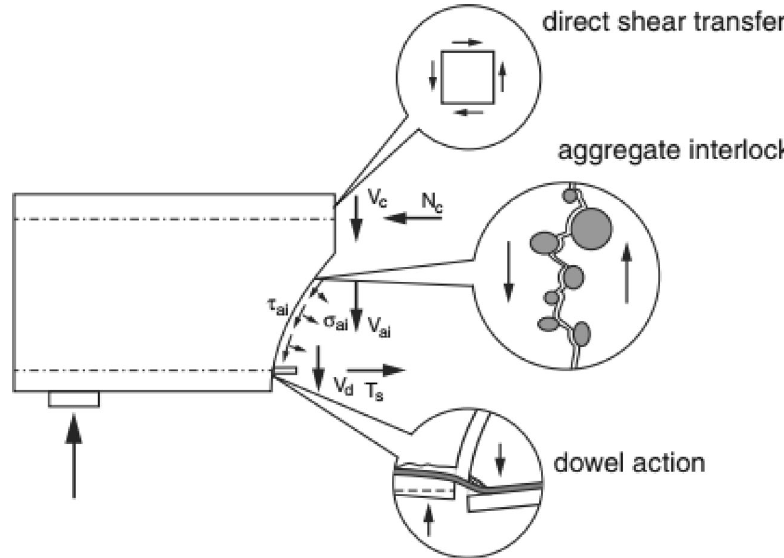
Fig. 1 Shear transfer mecha- nisms in a cracked